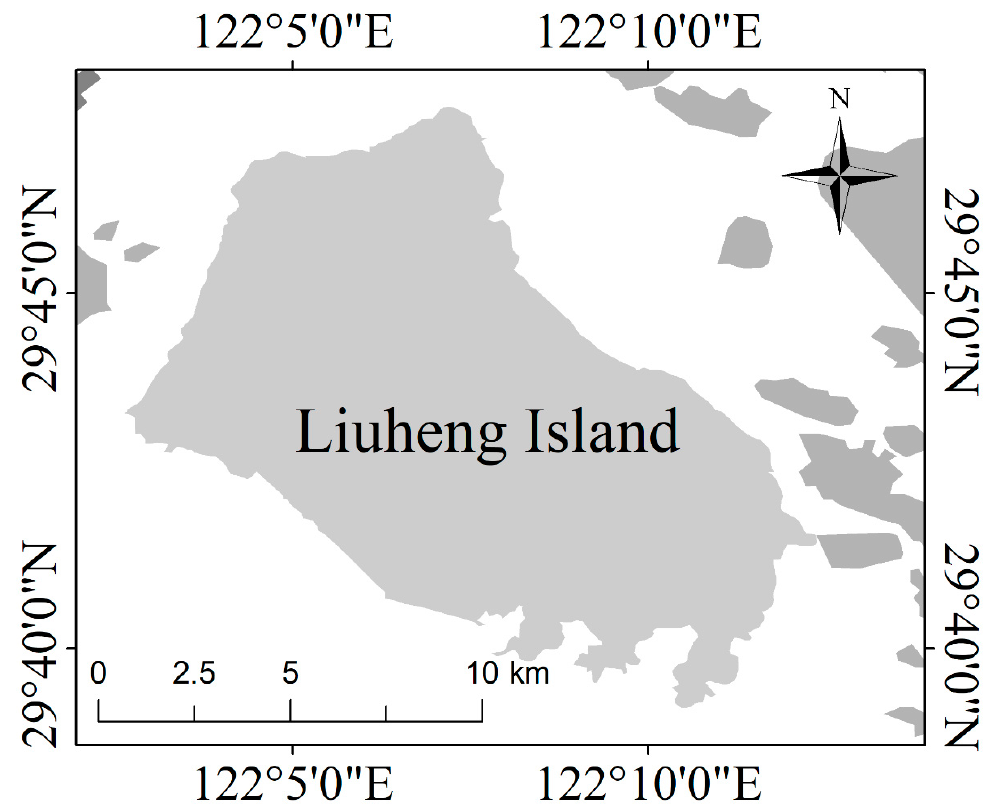
Figure 6. Location of Liuheng Island, China.